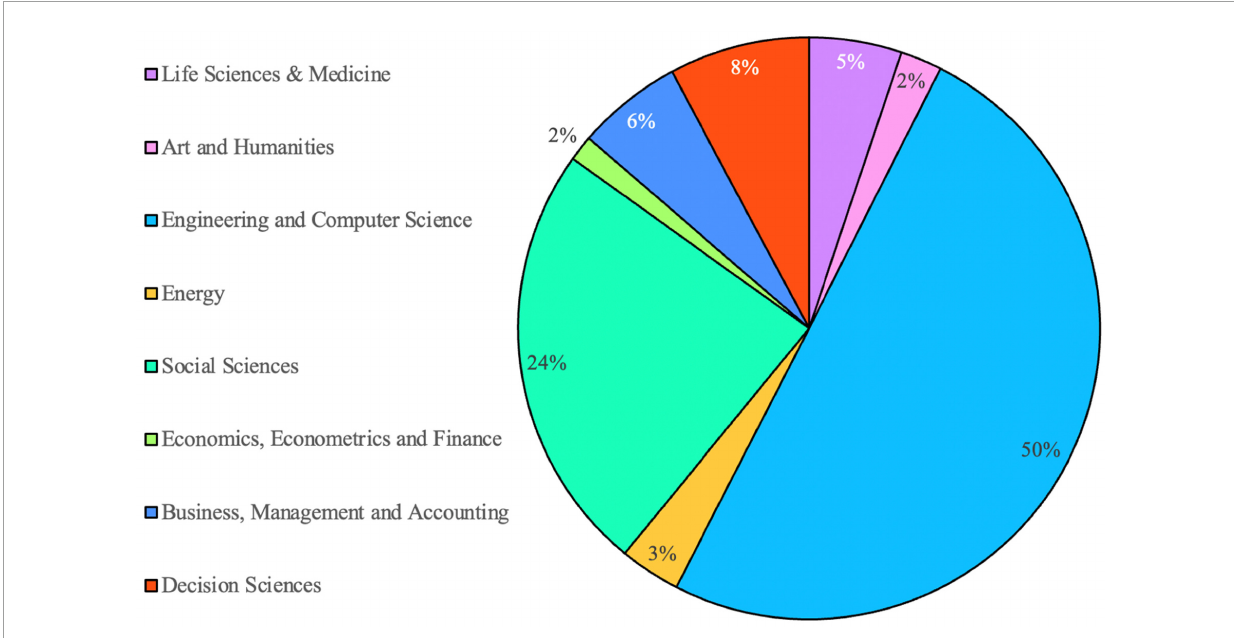
FIGURE1 The distribution of E.D. 4.0 articles, according to various subject domains, as of